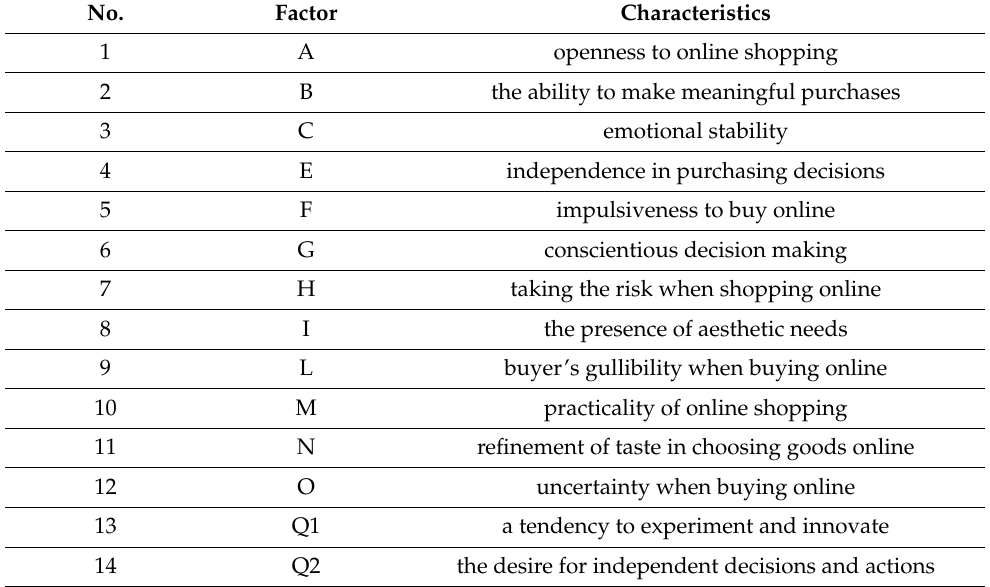
Table 1. Characteristics of the factors used in the adapted questionnaire. No.